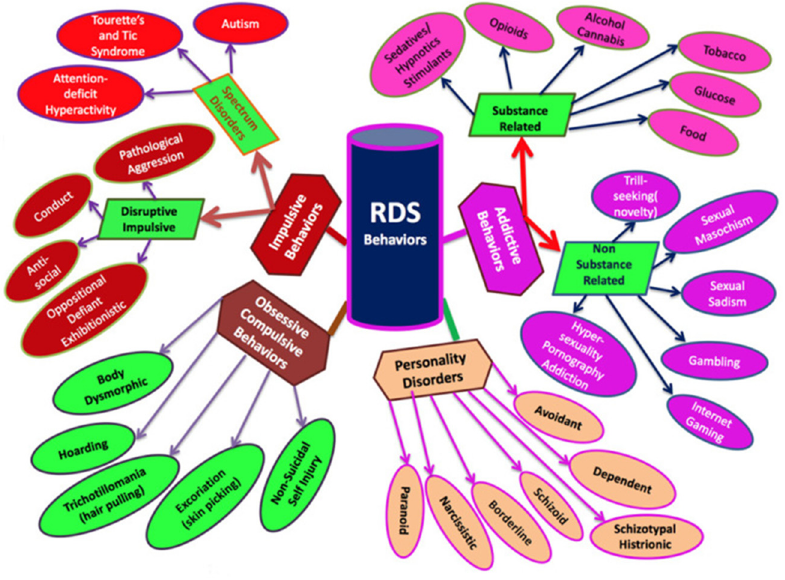
Figure 2. Reward Deficiency Syndrome schematic (with permission from Blum et al. [46]).